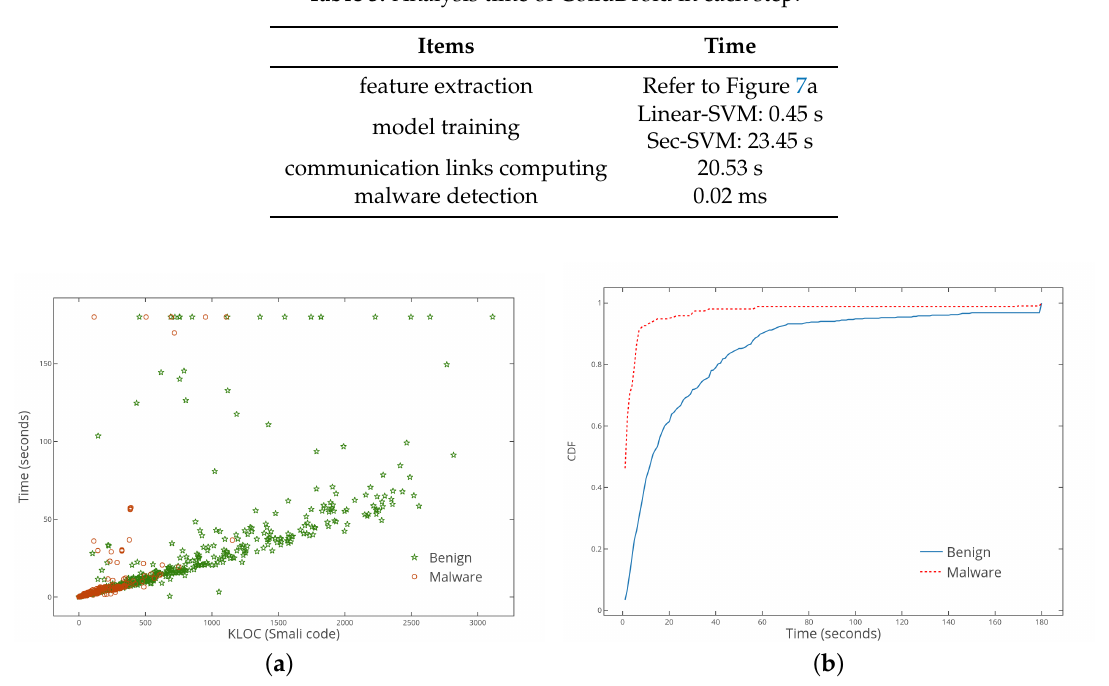
Table 3. Analysis time of ColluDroid in each step.